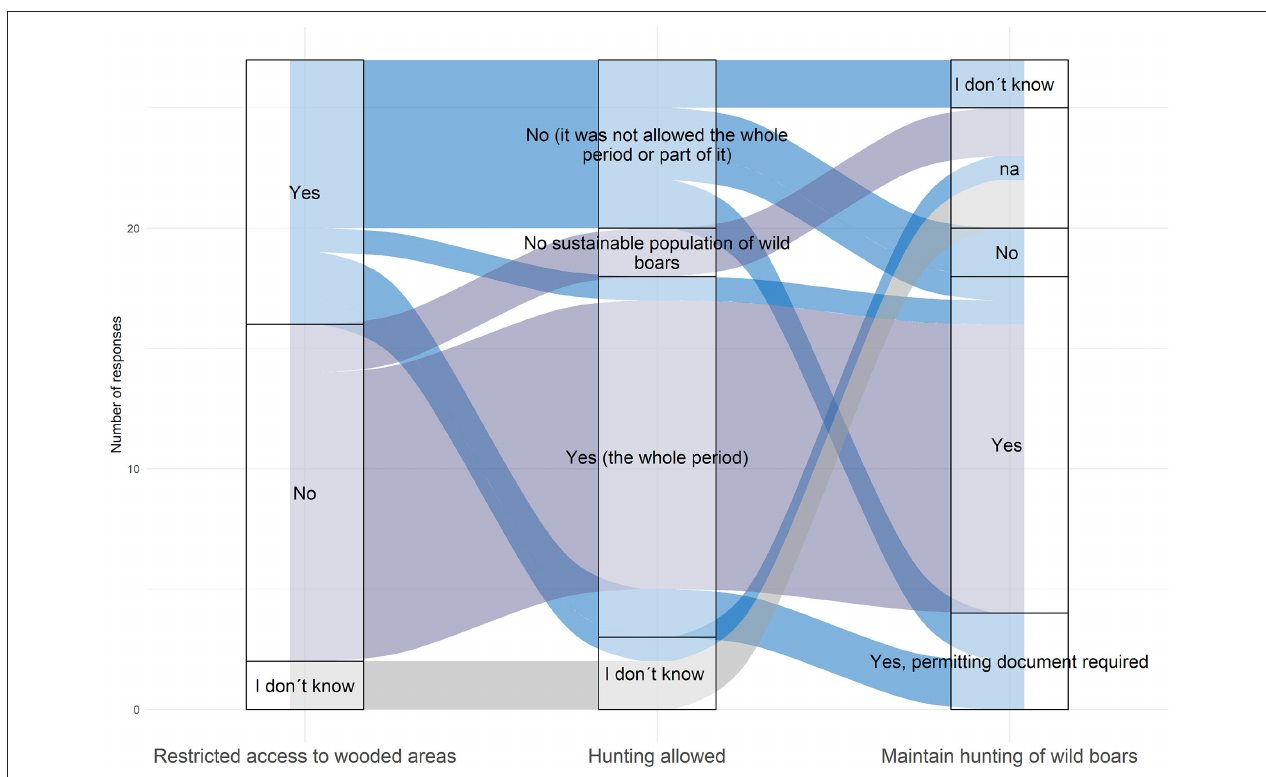
FIGURE 3 | Sankey diagram showing different modalities and adaptation of the wild boar hunting activities, over the period March-May 2020, as reported by the 27 survey participants from 24 countries (na: no